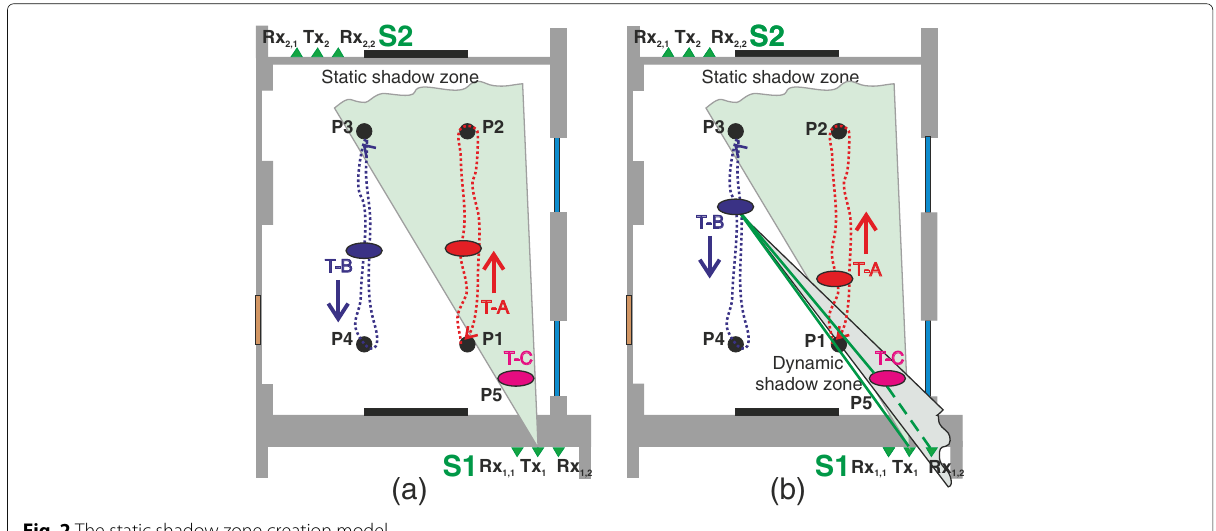
Fig. 2 The static shadow zone creation